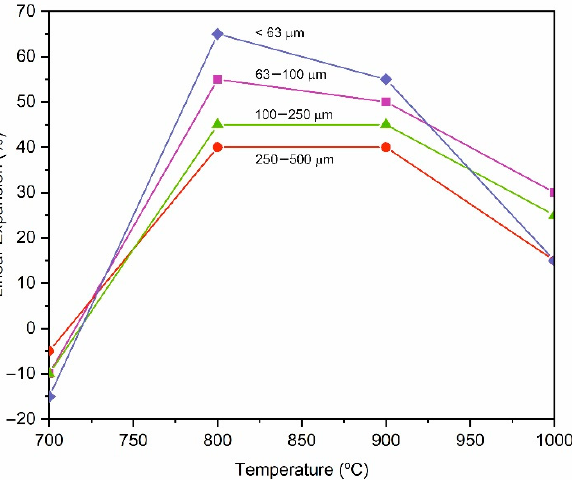
Figure 5. Evolution of linear expansion (LE) with temperature in pressed pellets of the composition GC–5ES formulated from different–particle–size glass cullet fractions and heat treated for 15 min.